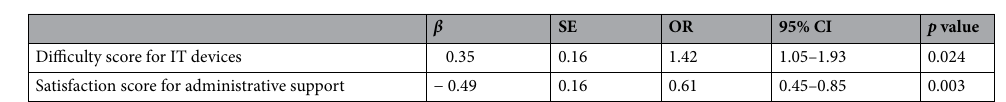
Table 3. Results of a binomial logistic regression analysis for mental illness. β standardized partial regression coefficient, SE standard error, OR odds ratio, 95%CI confidence interval.